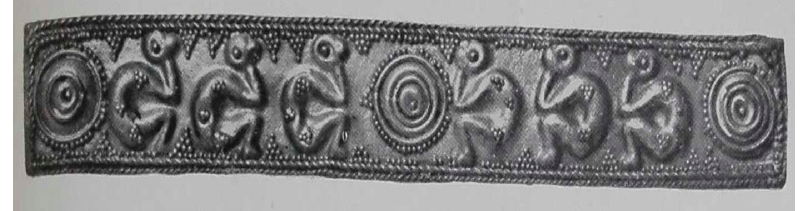
Figure 1. Central part of an Etruscan belt, Albegna, Italy (from Bonacelli 1932, modified).